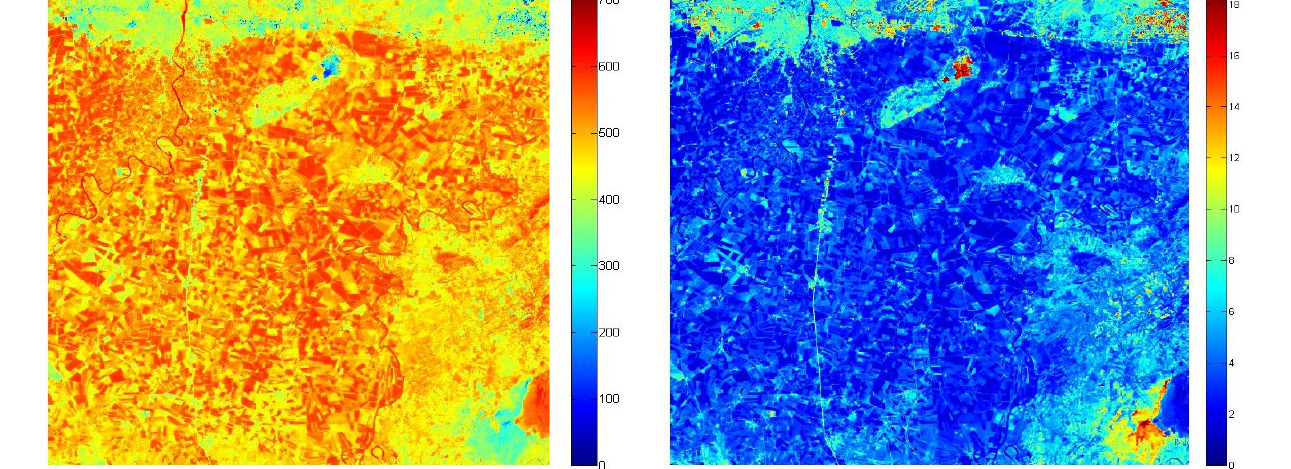
Figure 3. Instantaneous Net Radiation Map (W/m 2 )